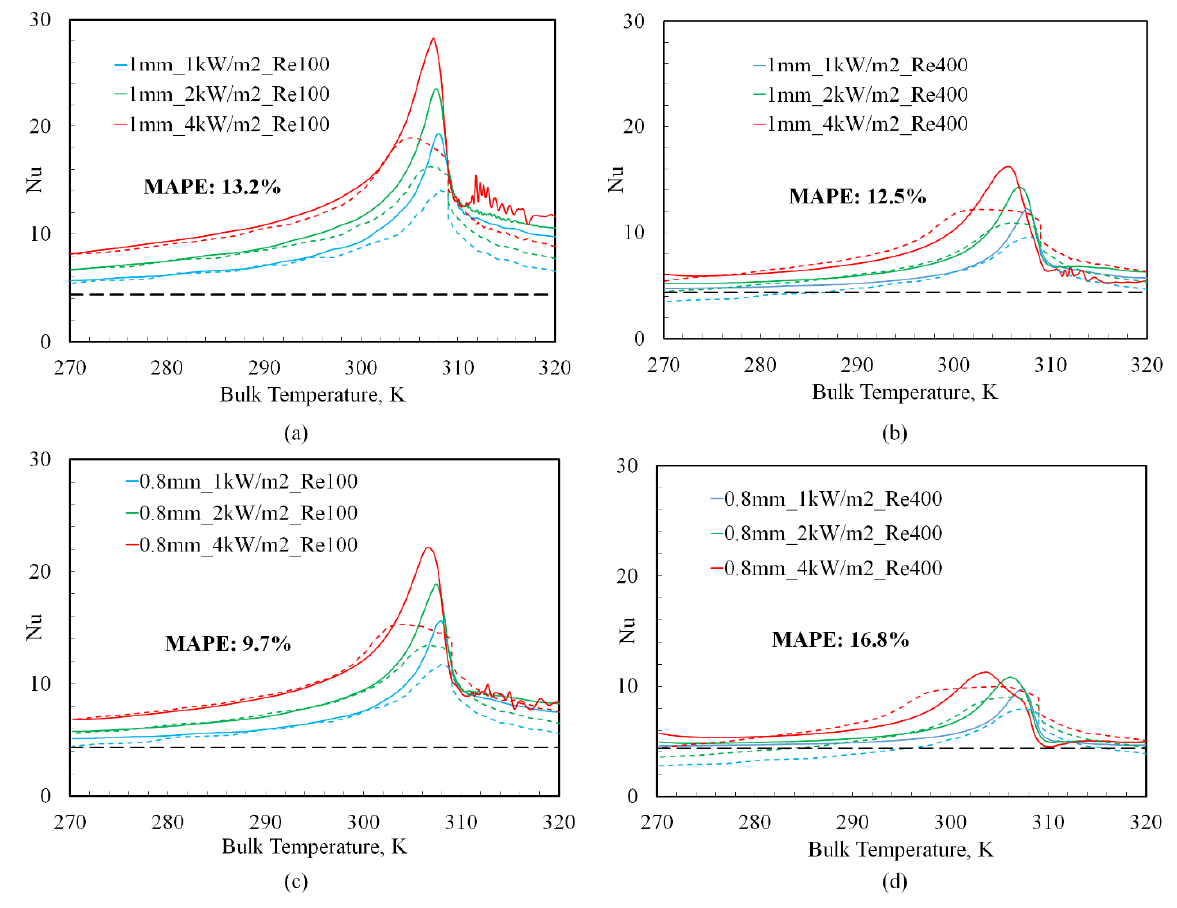
Figure 9. Equation (11) based predictions of Nu (dotted lines) versus bulk temperature (T BULK ) at tube diameters of 1 mm and 0.8 mm and different inlet Re: ( a ) 1 mm, Re 100; ( b ) 1 mm, Re 400; ( c ) 0.8 mm, Re 100; ( d ) 0.8 mm, Re 400. CFD-based Nu calculations are shown in bold lines. The values of B in Equation (11) were: 0.37 for T BULK < T PC and 0.35 for T BULK > T PC.